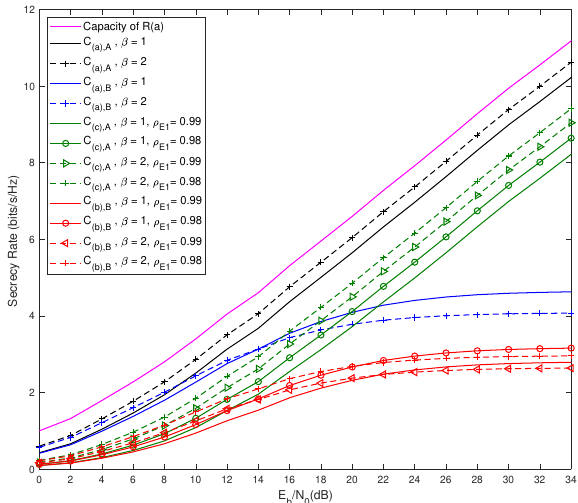
Figure 7. The secrecy rate of R ( a ) and R ( b ) , and in scenario B , e E 1 R = 0.02.